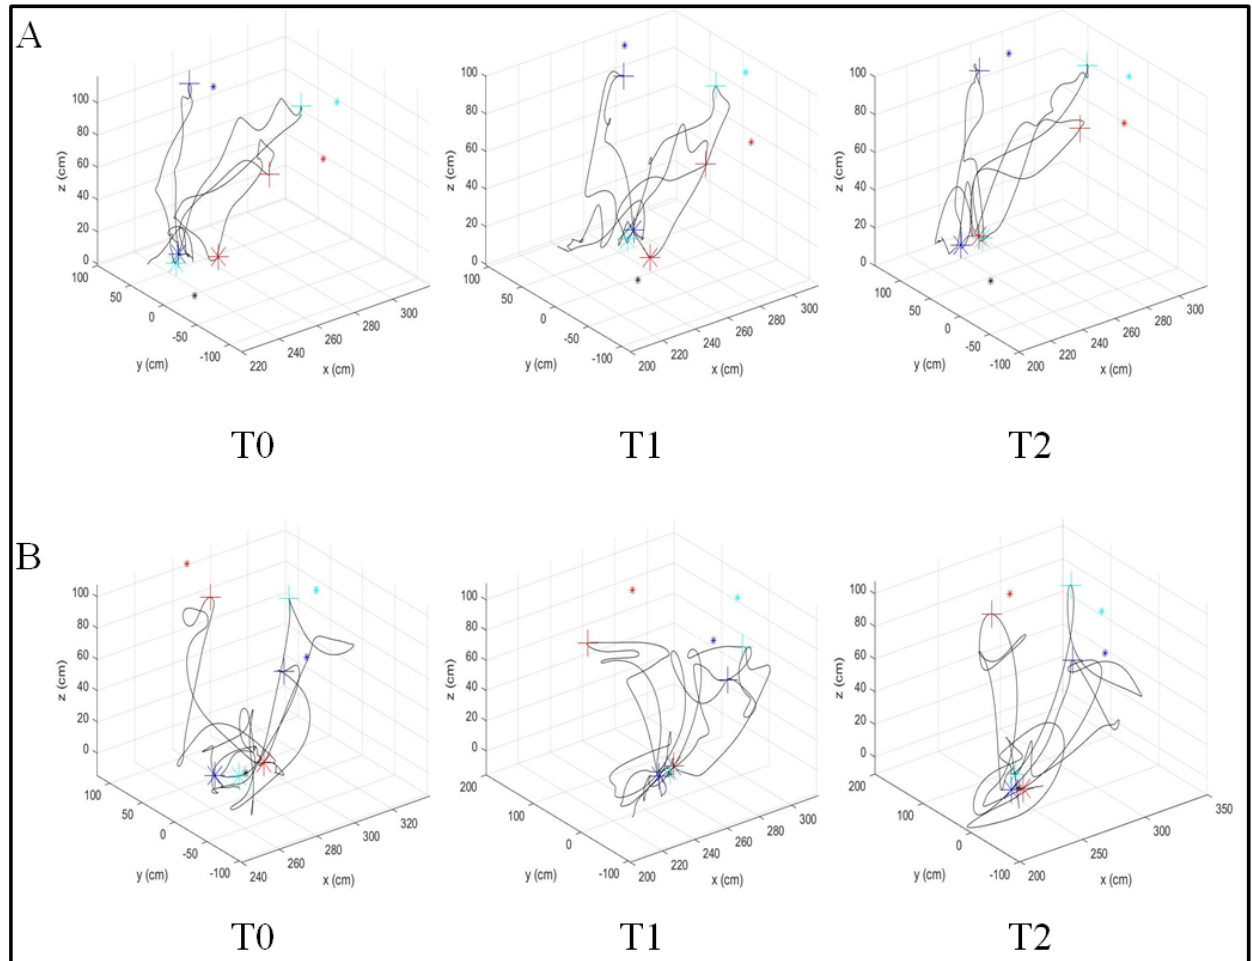
Figure 2. Example of 3D trajectory according to the reaching task of stroke patients in ( A ) the ACT group and ( B ) the ACAS group. This plot represents the actual trajectory in reaching the target. The asterisk represents the actual position of the target, the cross represents the hand position when the patient reaches the target. The red, cyan, and blue colors represent the medial, middle, and lateral directions, respectively.